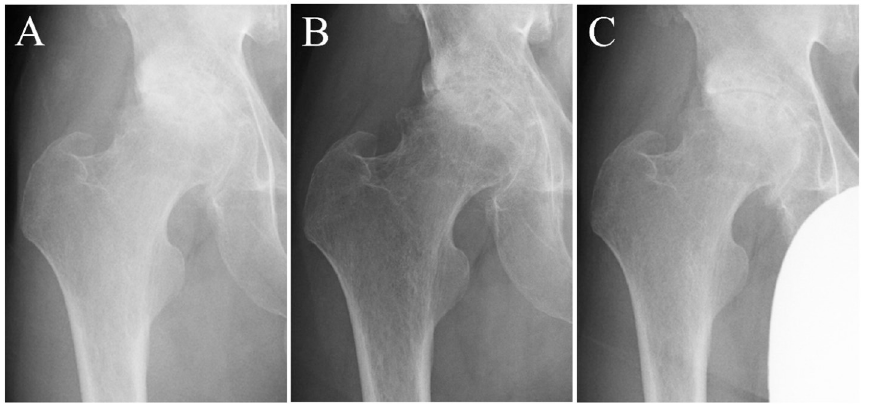
Fig 3. Recording from a single subject (patient A) showing radiographic changes in hip joint. At hospital admission (A), discharge (B), and at the 6-month post-discharge checkup (C).